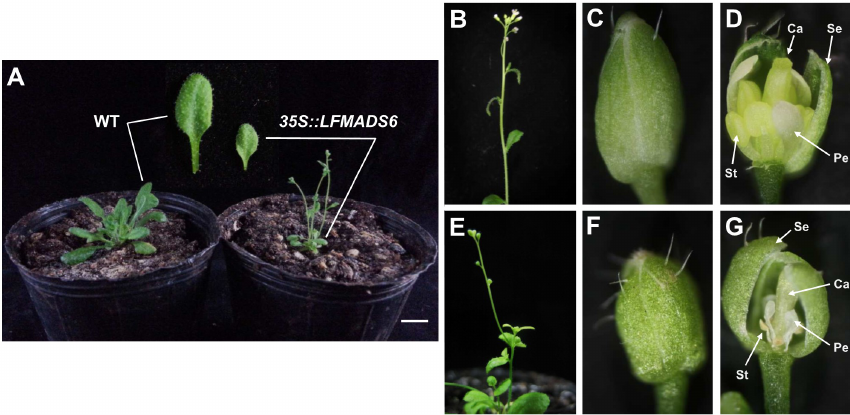
Figure 9. Overexpression of LFMADS6 promotes flowering and causes different effects on inflorescence structure and floral defect in Arabidopsis . ( A ) Phenotype of leaf shape and floral transition in wild-type (WT) (left) and 35S::LFMADS6 transgenic Arabidopsis (right) under long-day condition. Bar = 1 cm. ( B ) Inflorescence structure of WT. ( C ) The morphology of floral bud in WT. ( D ) Dissection of a wild-type floral organ with normal developing sepal, petal, stamen and carpel. ( E ) Inflorescence structure of 35S::LFMADS6 transgenic Arabidopsis . ( F ) The morphology of a floral bud in 35S::LFMADS6 transgenic Arabidopsis . ( G ) Dissection of a 35S::LFMADS6 transgenic Arabidopsis floral bud revealed the aborted petal and stamen in the second and third whorl, respectively. Se: sepal, Pe: petal, St: stamen, Ca: carpel.